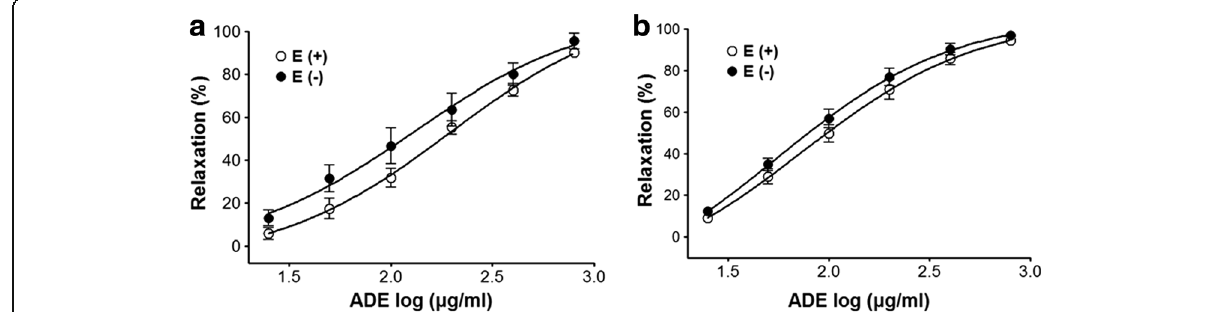
Fig. 2 Concentration-dependent relaxant effect of ADE on PE (1 μ M) ( a ) or KCl (60 mM) ( b ) precontracted endothelium-intact [(E+)] and endothelium-denuded [(E-)] aortic rings. Values are expressed as mean ± SEM ( n = 5 – 8, number of aortic